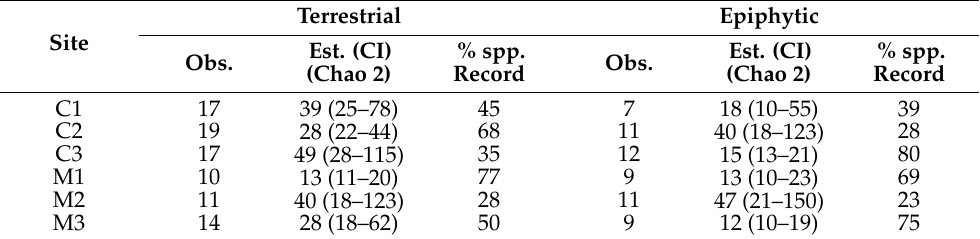
Table 1. Observed (Obs.) and estimated (Est.) richness for terrestrial and epiphytic mosses among the study sites (C = conserved; M = managed) by Chao 2 index. CI = Confidence intervals; % spp. record = percentage of species recorded.